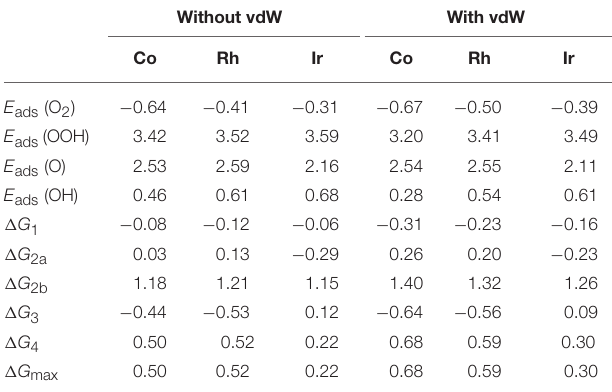
TABLE 1 | The E ads and 1 G of ORR intermediates at the potential U = 0.4V with and without the vdW corrections. Without